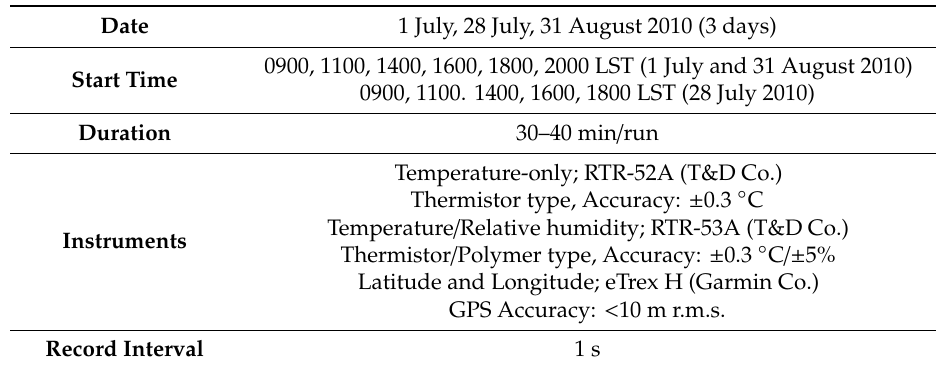
Table 1. Outline and instruments of mobile